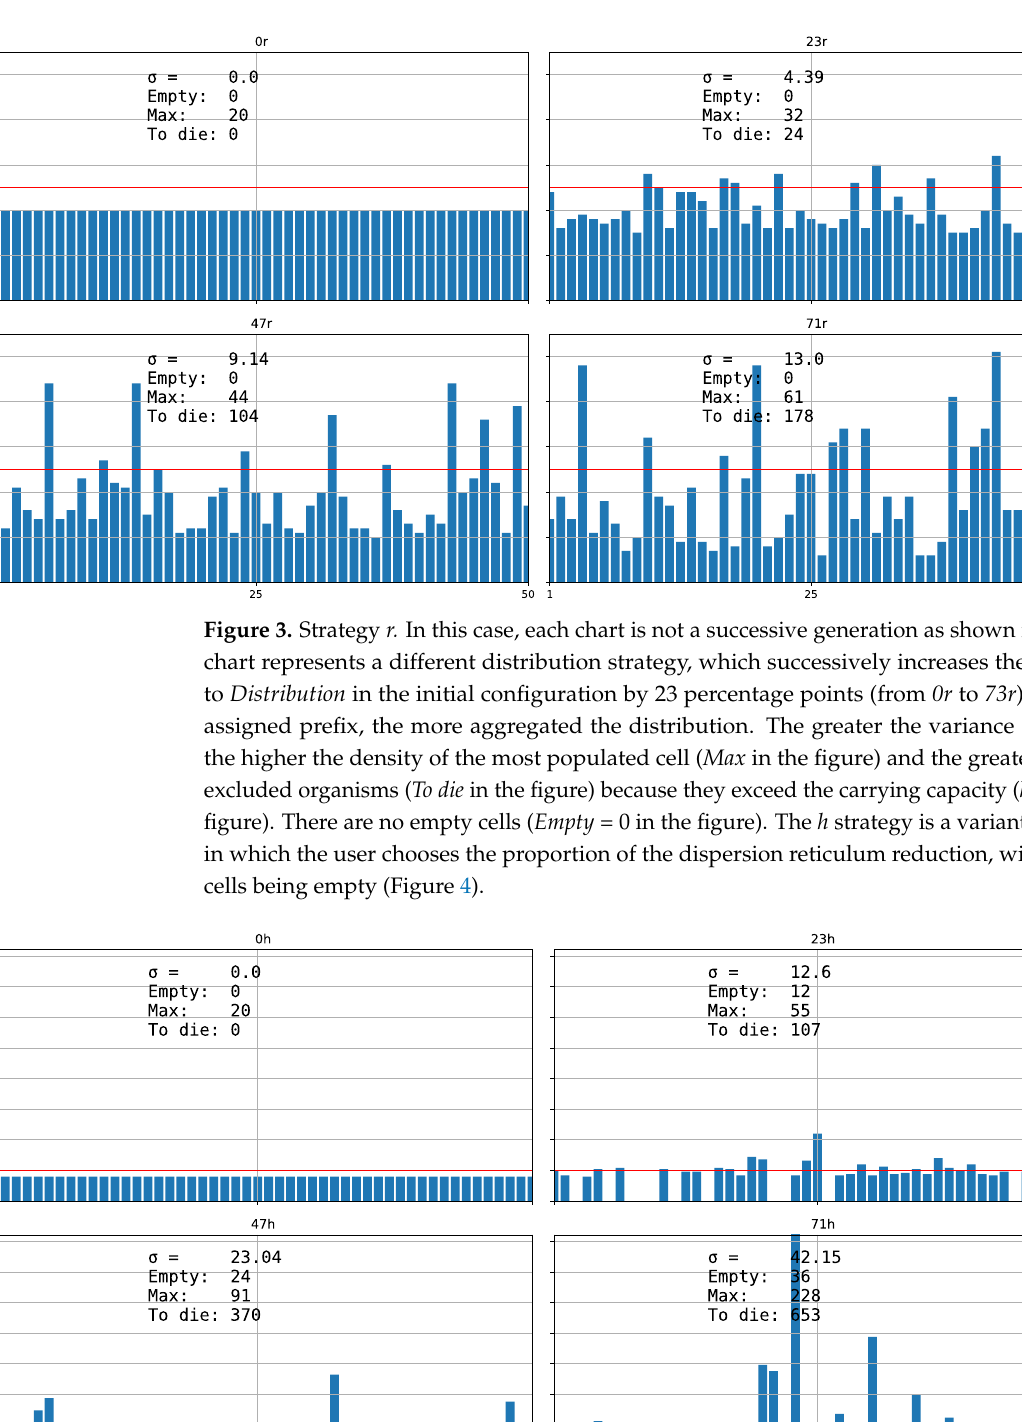
Figure 2. We represent a distribution generated by ECA for Distribution = 100r of a population of 5,000,000 organisms. The X -axis represents the density of each cell and the Y -axis is the number of cells. The skewness coefficient is positive (2.08) and the standard deviation is 24,738.08. It is a nega- tive binomial distribution.